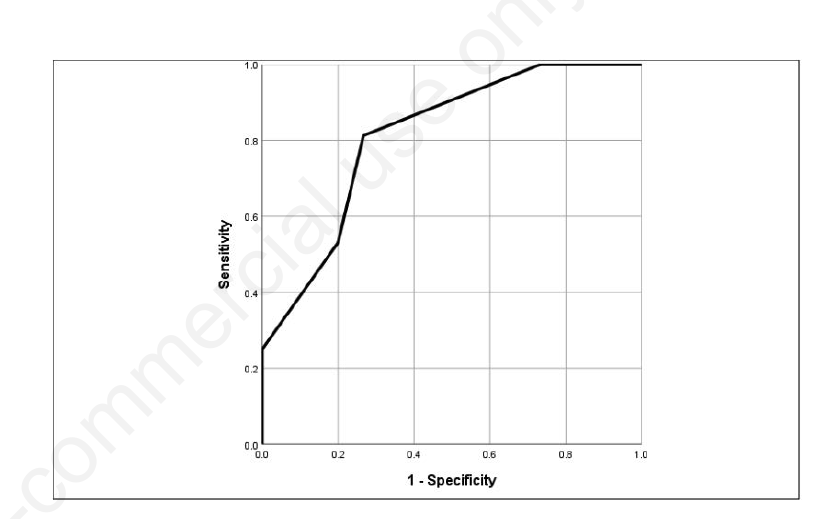
Figure 2. ROC curve of “days of using per